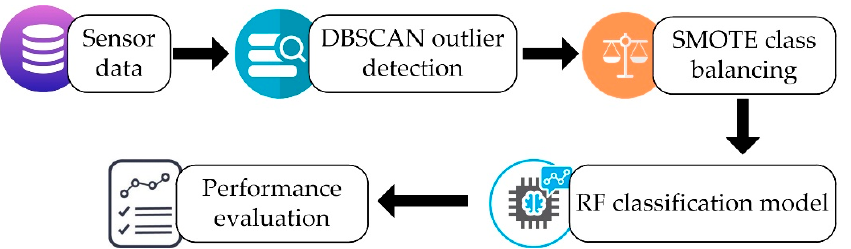
Figure 4. Hybrid fault model using density based spatial clustering of applications with noise (DBSCAN) outlier detection, synthetic minority oversampling technique (SMOTE) class balancing and random forest (RF) classification model.